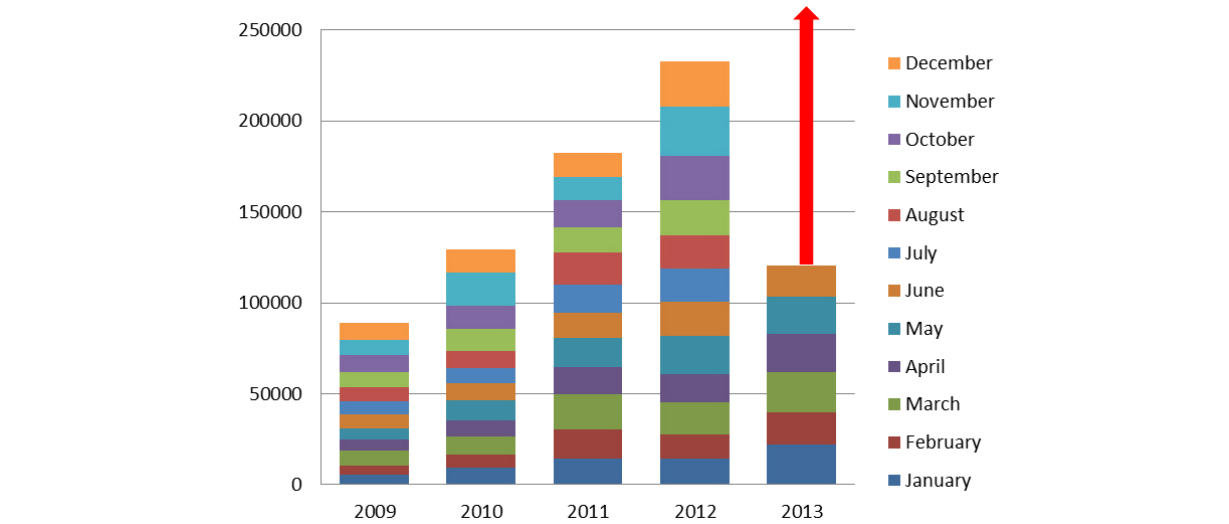
Figure 4. Graphical display of increased Web traffic on